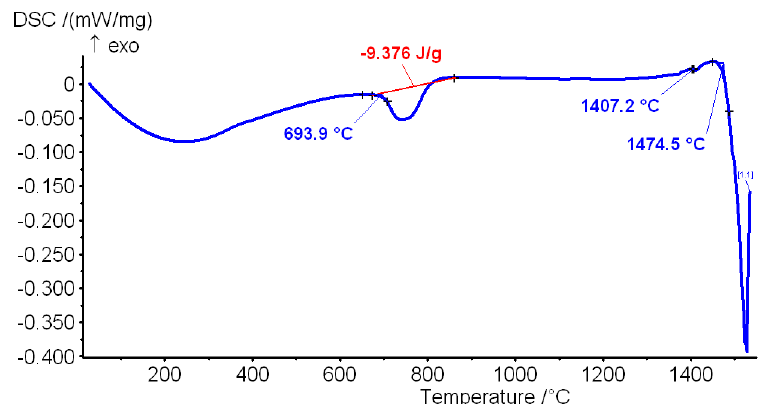
Figure 10. Differential scanning calorimetry (DSC) heating curve of the steel of the tooth body.